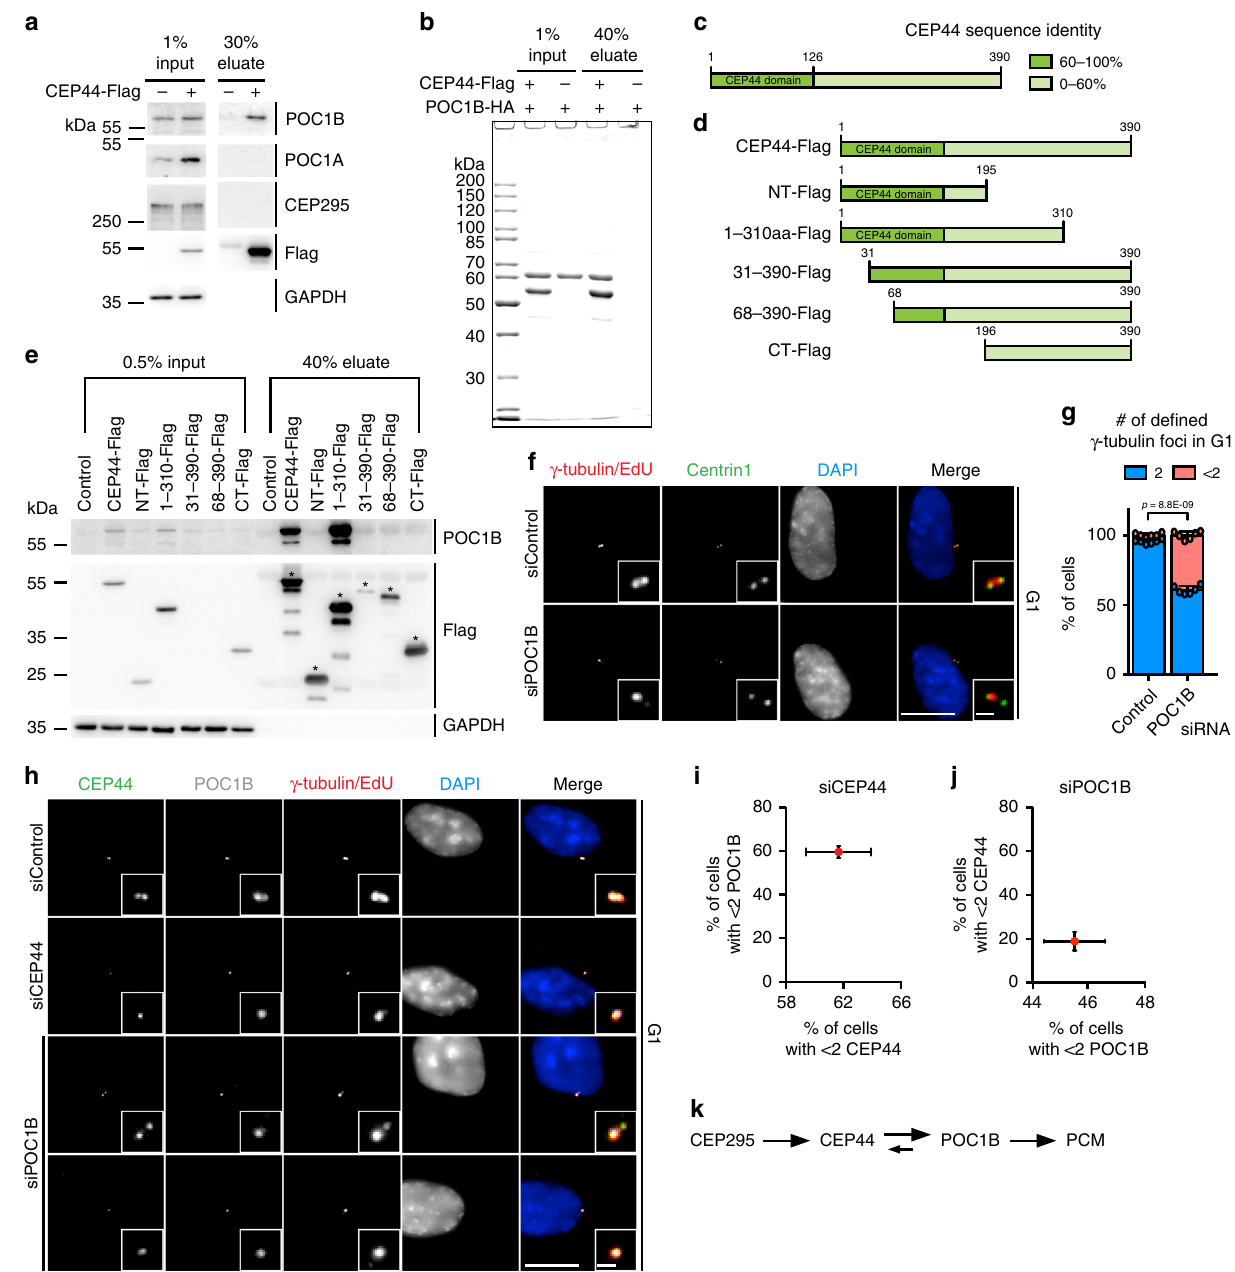
Fig. 3 The CEP44-POC1B complex is needed to convert centrioles to centrosomes. a Anti-Flag IP using CEP44-Flag from RPE1 cells was analysed for POC1B, POC1A and CEP295 by immuno-blotting (IB). GAPDH was used as input control. b Coomassie Blue stained gel of in vitro binding between puri fi ed, recombinant CEP44-Flag and puri fi ed, recombinant POC1B-HA. See Supplementary Fig. 5b for IB and 5c for Coomassie Blue stained gels of puri fi